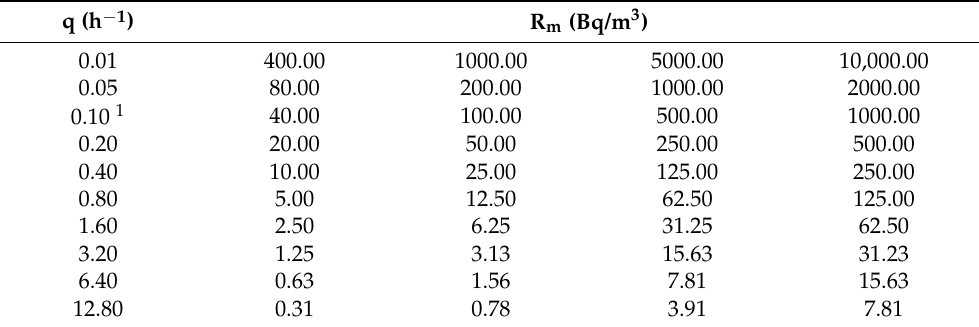
Table 1. Decline in the radon contribution to the indoor-air radon concentration from indoor materials. q is the air change per